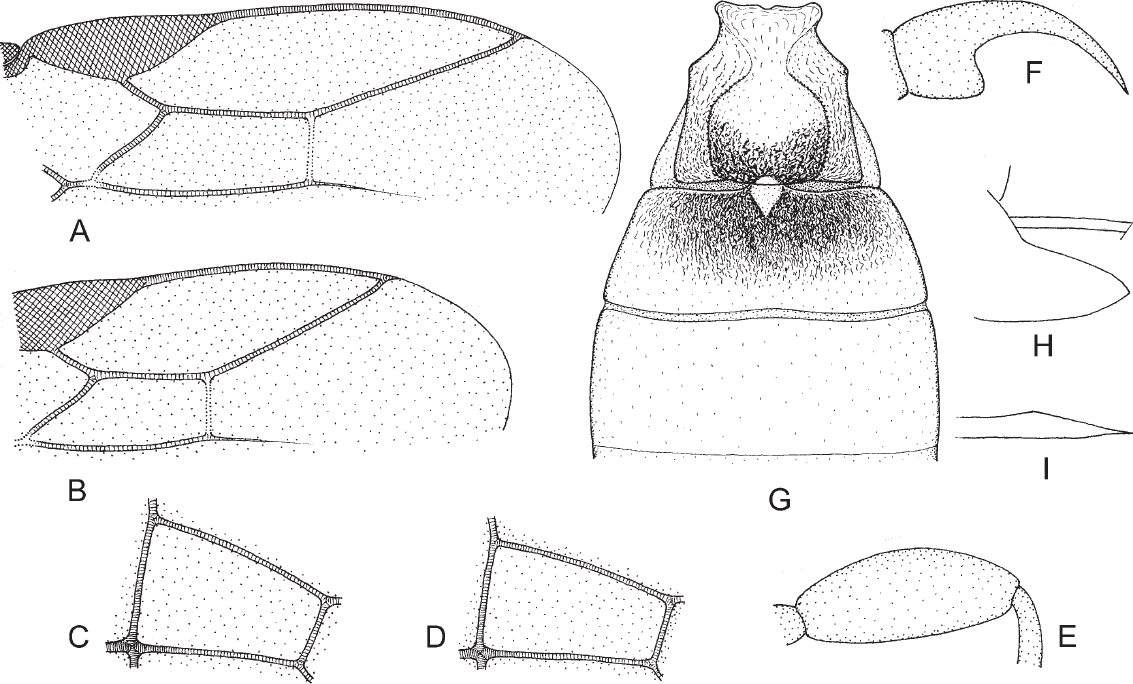
Fig. 17. Bracon ( Lucobracon ) fumigidus Szépligeti, 1901 (A, C: ♀ lectotype, B, D-F: ♀ / ♂, H-I: ♀). A-B . Distal part of right forewing. C-D . First discal cell of right forewing. E . Hind femur. F . Claw. G . Tergites 1-3. H . Hypopygium. I . End of